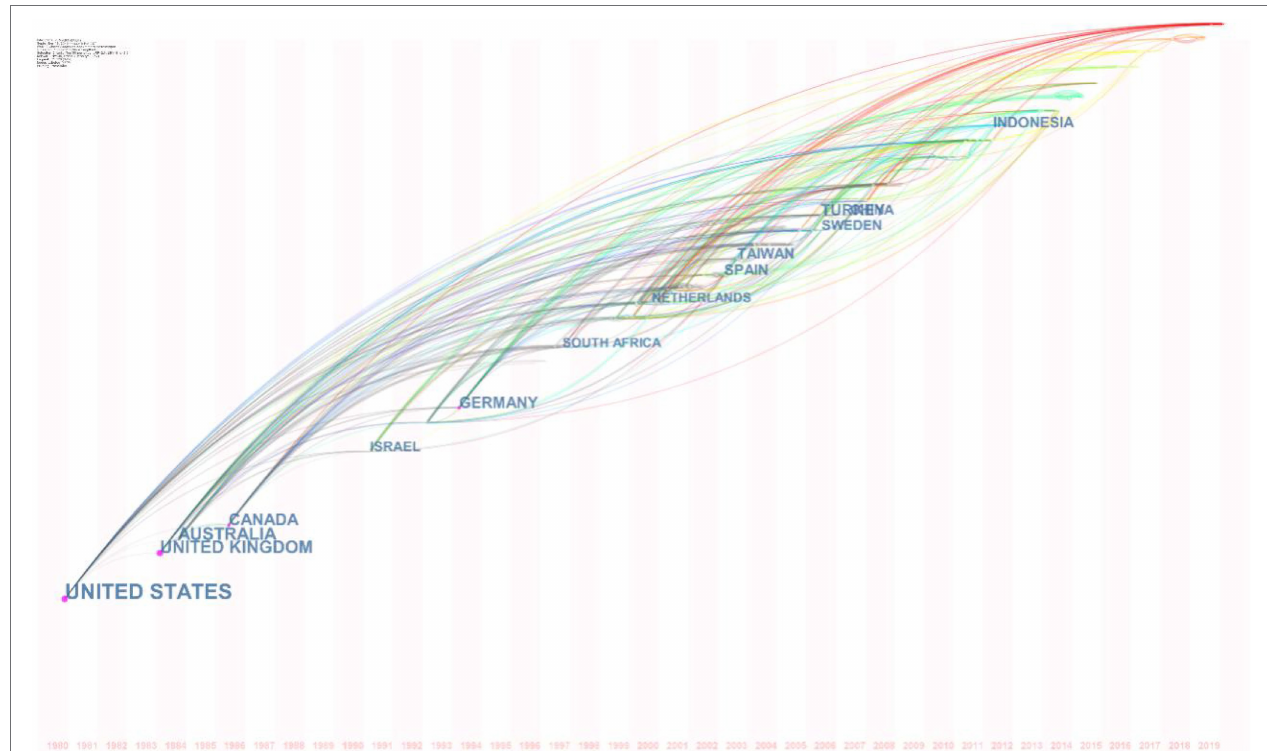
FIGURE 6 | Time zone evolution of intellectual growth of scientific literacy between the years 1980 to